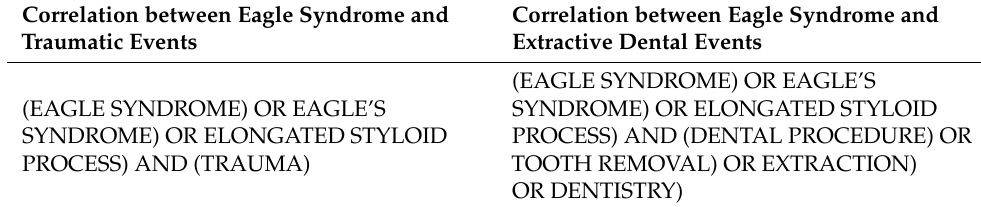
Table 1. Search strategy. Correlation between Eagle Syndrome and Traumatic Events (EAGLE SYNDROME) OR EAGLE’S SYNDROME) OR ELONGATED STYLOID PROCESS) AND (TRAUMA)